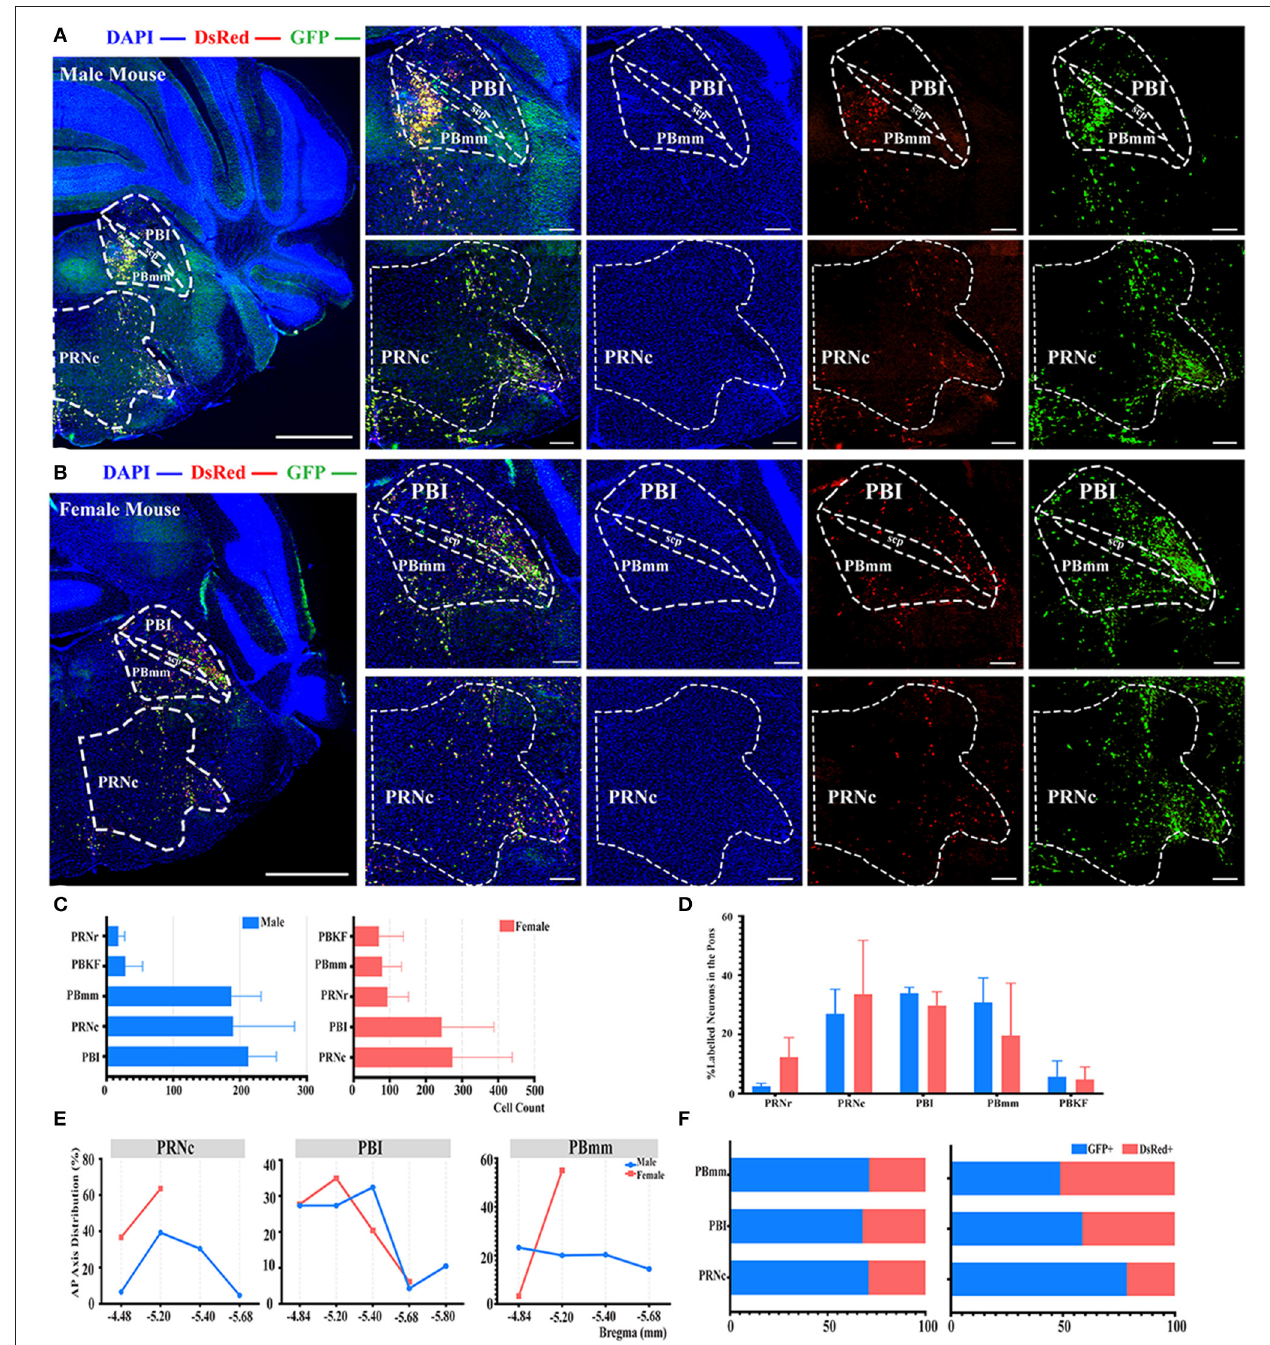
FIGURE 6 | Distribution patterns of labeled neurons in the Pons. (A,B) Representative images showing labeled neurons from the mouse ipsilateral pons to the ELGs. Scale bar: 1mm (left lower magnification images) and 200 µ m (right higher magnification images); ( A , male; B , female). (C) Number of labeled neurons (GFP + and dsRed + ) in different subregions of Pons (left, male; right, female). (D) Distribution of the labeled neurons within Pons (significant difference labeled on the bar top, otherwise n.s.). (E) Distribution patterns of the labeled neurons along the AP axis in different subregions of Pons. (F) Distribution of GFP + and dsRed + within subregions of Pons (left, male; right, female). GFP + , PRV-GFP positive neurons; dsRed + , PRV-dsRed positive neurons. n.s., no significant difference.